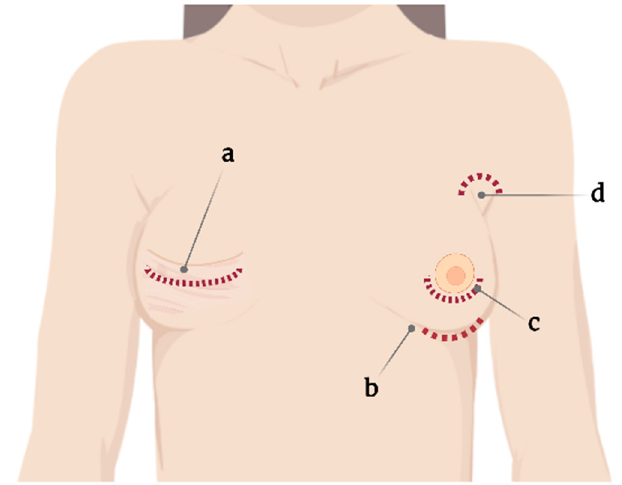
Figure 1. Current incision sites for silicone breast implant placement. ( a ) Mastectomy scar, ( b ) submammary, ( c ) periareolar, and ( d ) axillary.